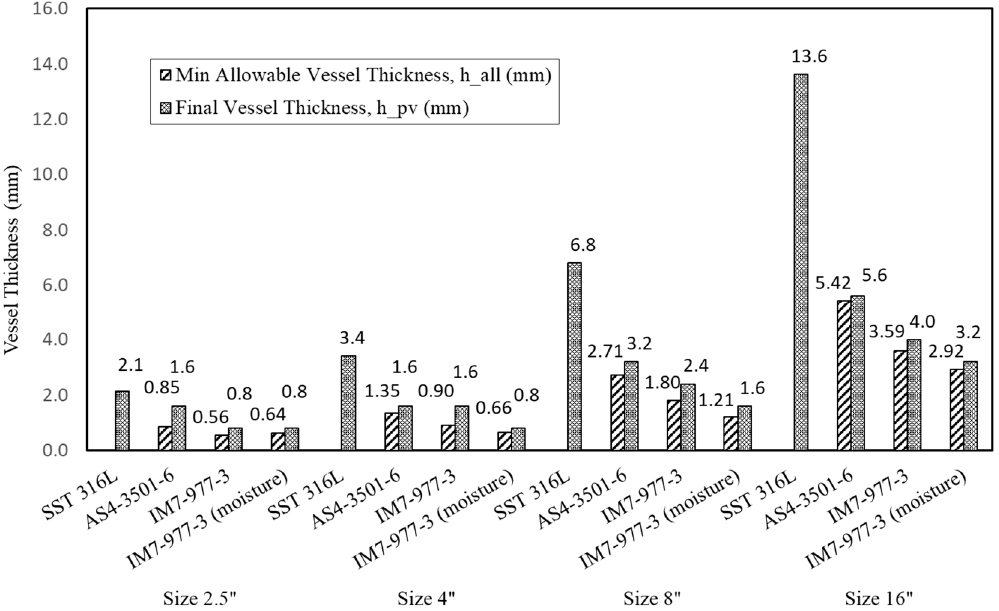
Figure 10. The allowable PV thicknesses and the composites final PV thicknesses after approximating to an integer number of basic laminates. Table 4. Weight, safety factor and optimum lay-up comparison for all solutions.